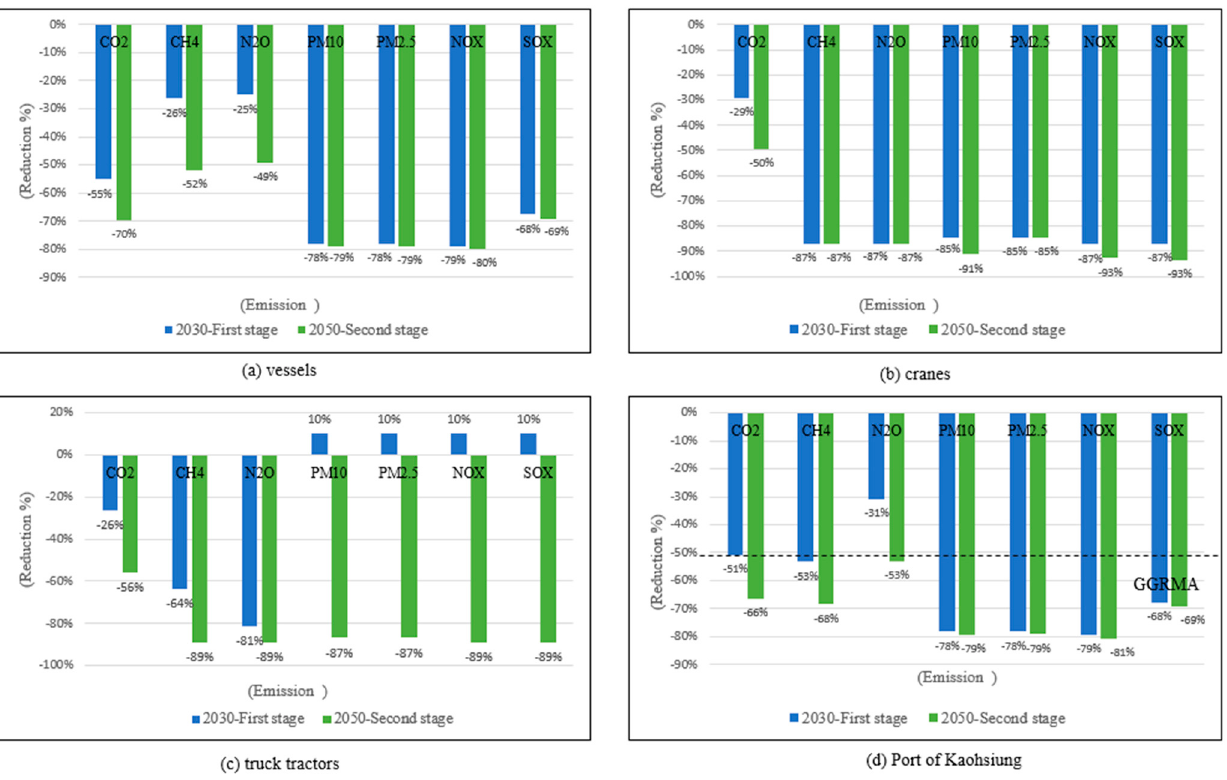
Figure 5. The emissions from vessels, cranes, truck tractors, and the Port of Kaohsiung using reduction policies in the second stage.